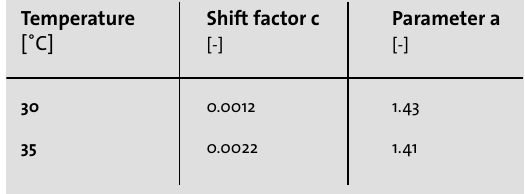
Table 4 (left): Parameters of the generalized Cox-Nerz rule for cream cheese. Table 5(right): Deviation from Cox-Merz rule as mea- sured by the ratio of dynamic viscosity ampli- tude, | h* | to apparent steady shear viscosity, h